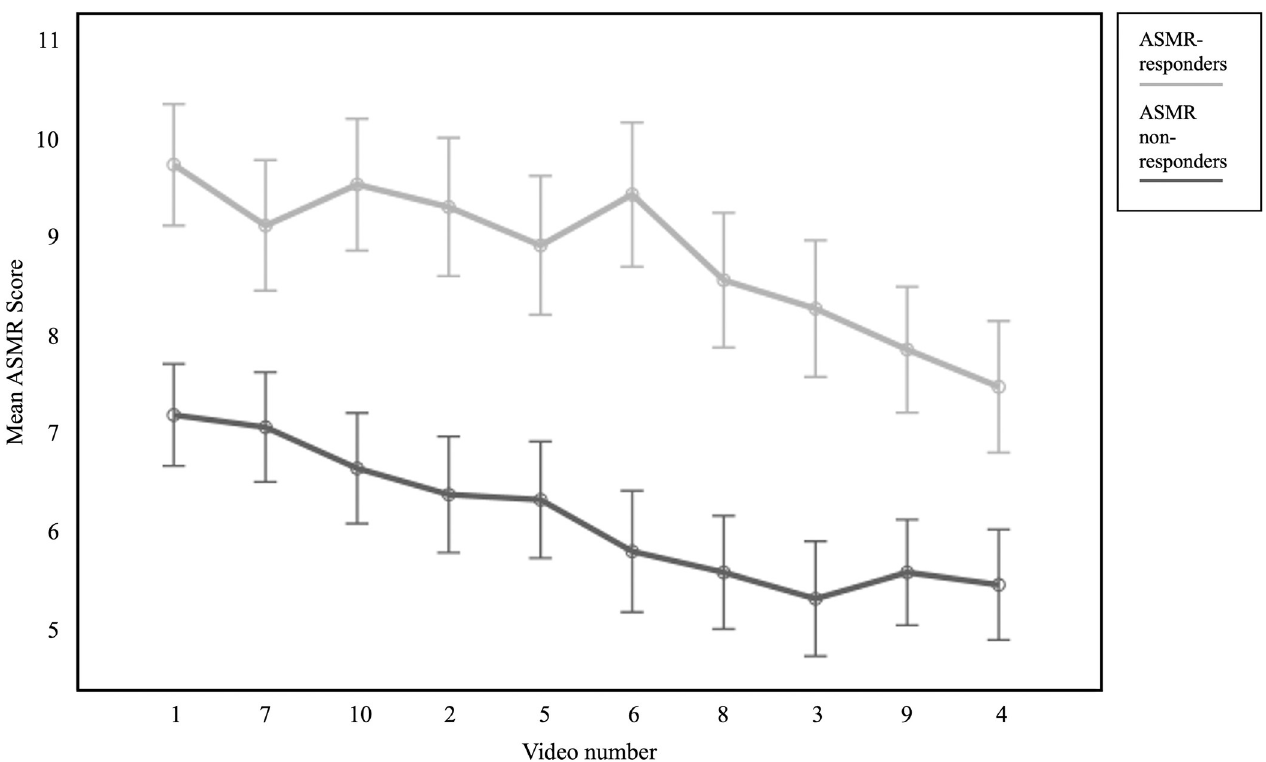
Fig 2. Average ASMR scores for each of the ten ASMR videos subdivided for ASMR-responders and ASMR non-responders with the videos being sorted by the amount of ASMR experience (main effects of video and observer type).